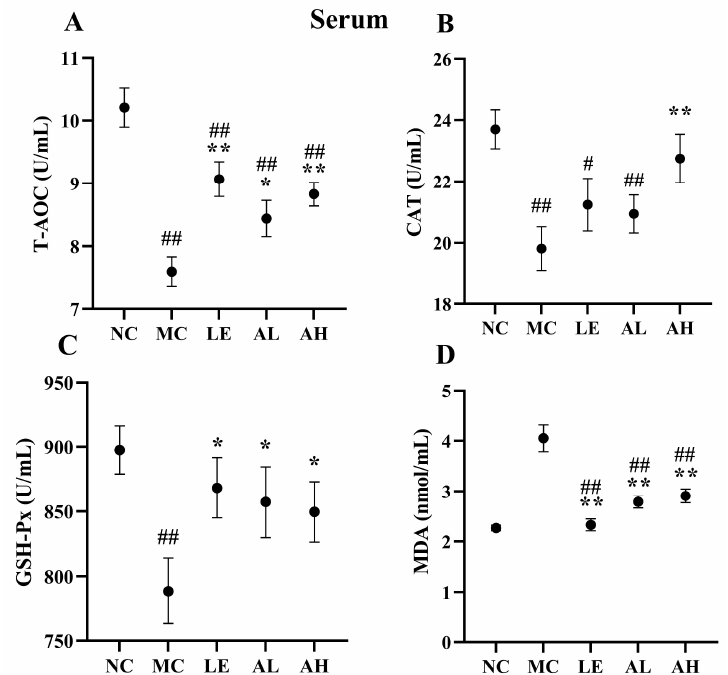
Figure 4. Effects of AAPS on the antioxidant capacity in serum of mice ( n = 10 per group). ( A ) T-AOC. ( B ) CAT. ( C ) GSH-Px. ( D ) MDA. LE, 300 mg/kg.bw/d Lentinan; AL, 300 mg/kg.bw/d AAPS; AH, 600mg/kg.bw/d AAPS. Data are presented as the means ± SEM. # p < 0.05, ## p < 0.01 vs. NC group. * p < 0.05, ** p < 0.01 vs. MC